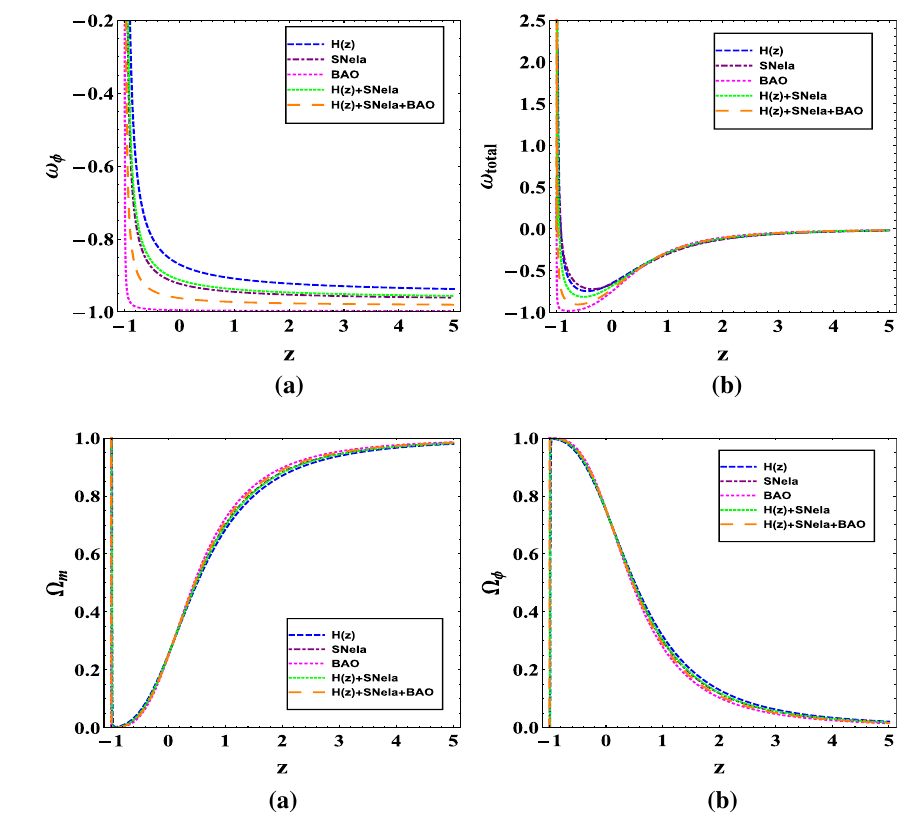
Fig. 7 a and b Highlight the behaviours of density parameter of matter and scalar